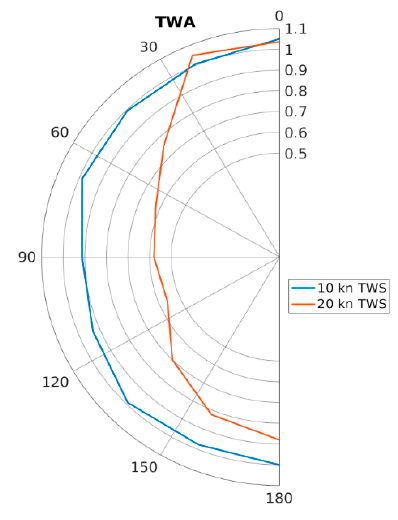
Figure 5. Relative propulsion power over the true wind angle (TWA) for the RoPax ferry, ship speed = 16 kn.